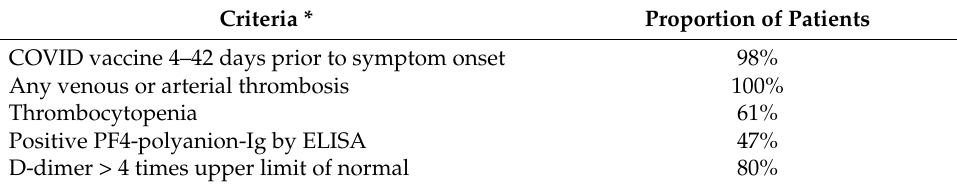
Table 2. Summarized criteria for VITT syndrome from our CVST patient population (32/41 studies). Criteria